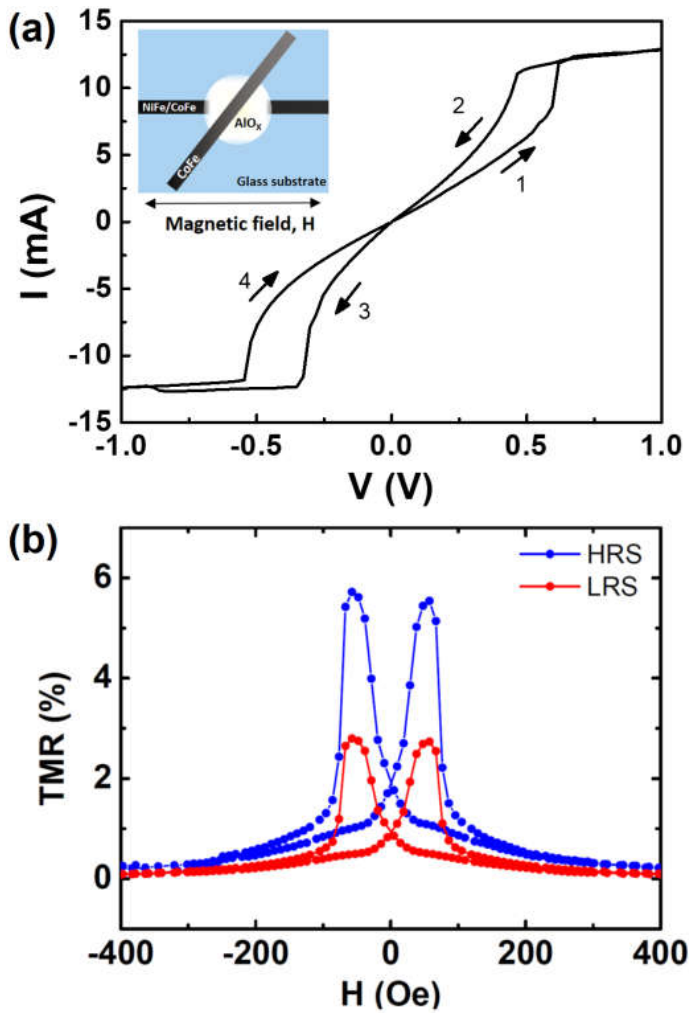
Figure 1. ( a ) Current–voltage (I–V) curve of a NiFe/CoFe/AlO x /CoFe RS memory device with arrows indicating the directions of the voltage sweep. Note that the threshold setting and resetting voltage was about 0.6 V and − 0.6 V, respectively. ( b ) The room-temperature TMR as a function of the magnetic field measured at 2 mV for HRS and LRS, respectively. The inset shows the scheme of the device structure.